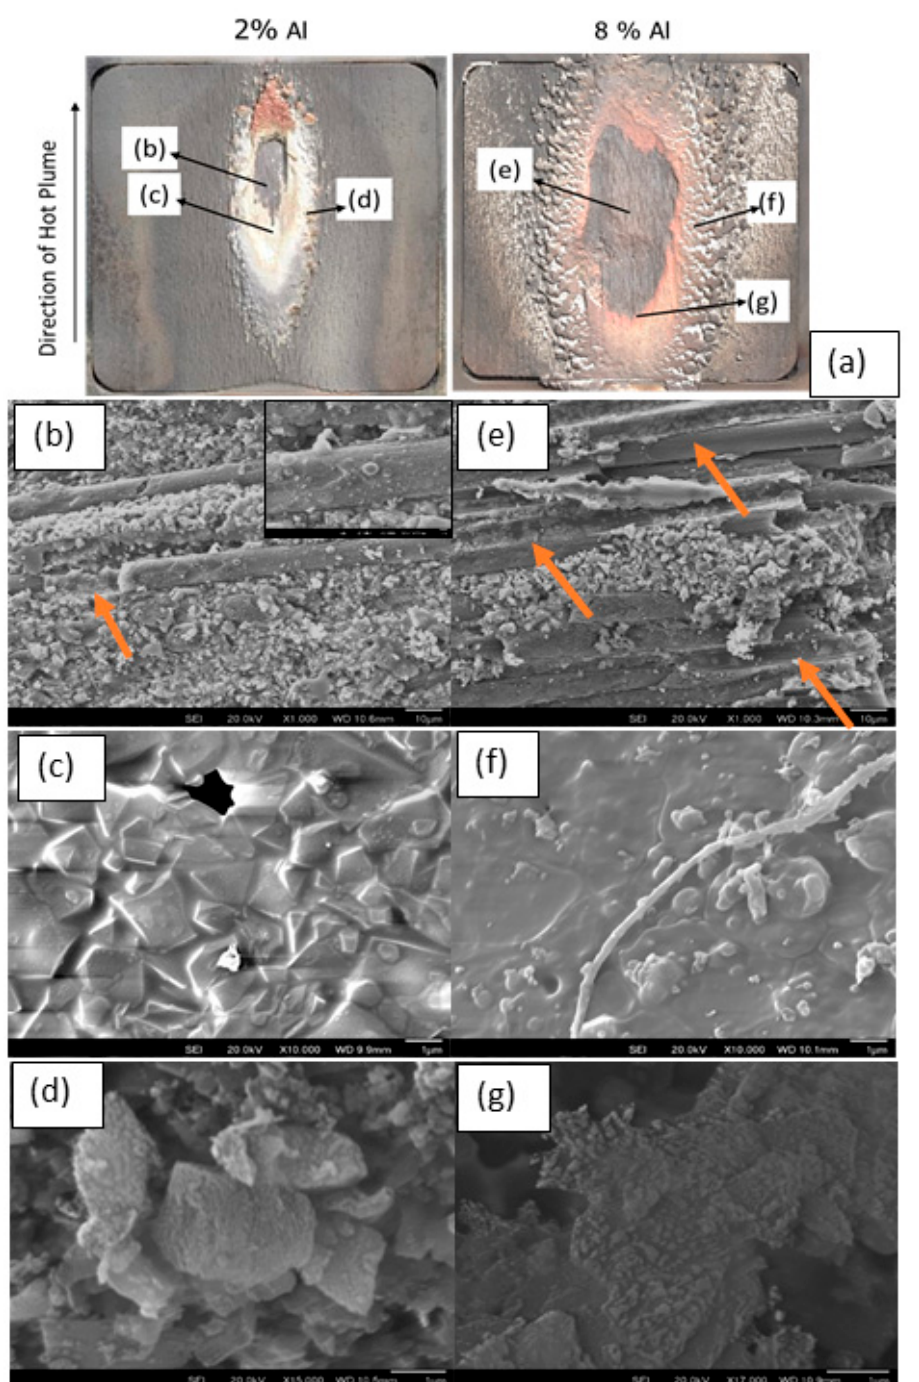
Figure 13. SEM images of the ablated front side of the sample obtained after using ( b – d ) 2% Al and ( e – g ) 8% Al propellant and ( a ) refers to the image location on the samples.